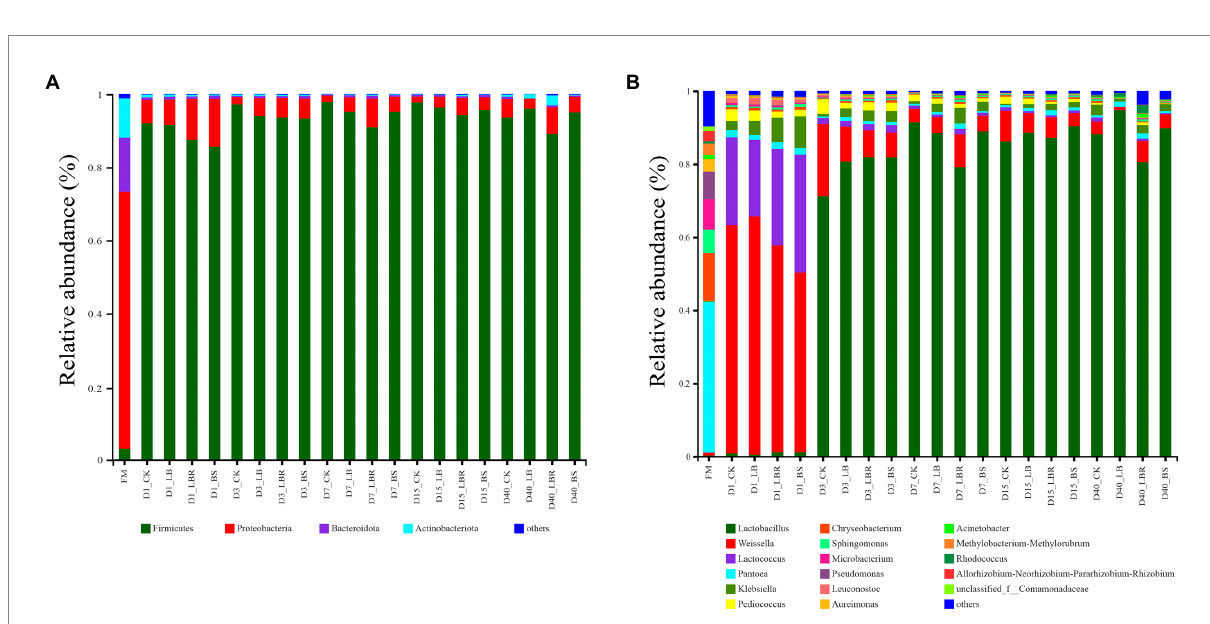
FIGURE 2 Relative abundance of bacterial communities at the phylum (A) and genus levels (B) in sorghum-sudangrass silage after ensiling for 1, 3, 7, 15, and 40 days (FM, fresh matter; CK, control; LB, Lactobacillus buchneri ; LBR, Lactobacillus brevis; BS, Bacillus subtilis